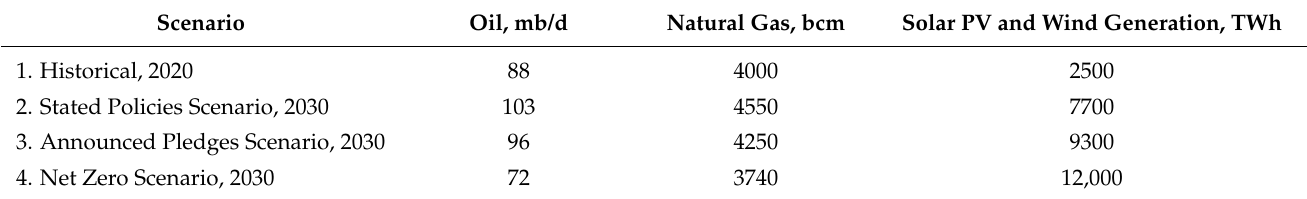
Table 1. Demand for fossil